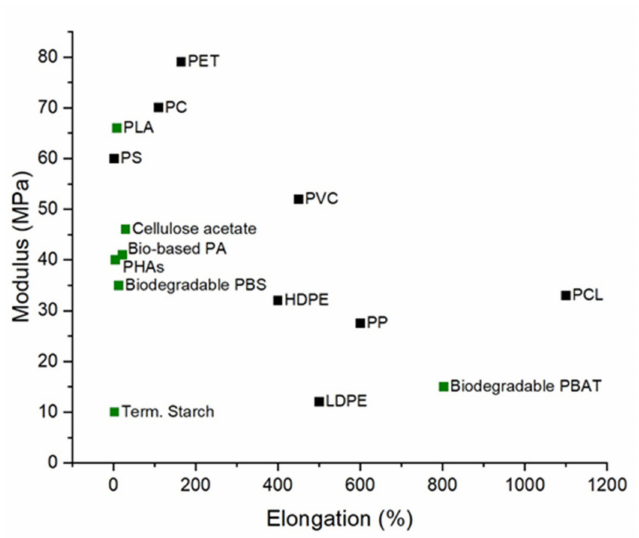
Figure 2. Maximum Tensile Strength (MPa) and Maximum Tensile Elongation (%) of bioplastics compared to petroleum-derived plastics, Data from Ref.